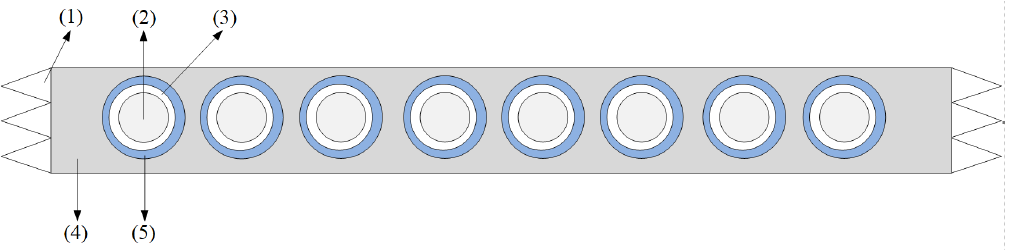
Figure 3. The sensing armband structure, including ( 1 ) Velcro, ( 2 ) hemispherical silicone pad, ( 3 ) force morphology sensor, ( 4 ) elastic fabric band and ( 5 ) flat button. The mechanical coupler is placed on the sensing head.